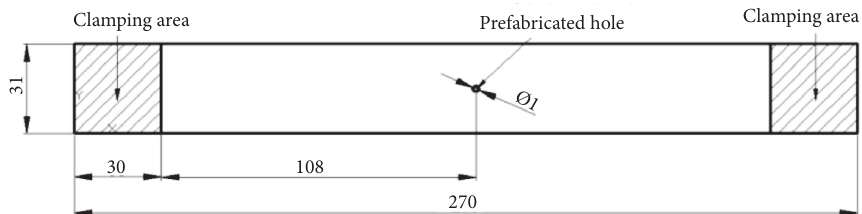
Figure 4: Structure and dimension of CFRP laminated plates.